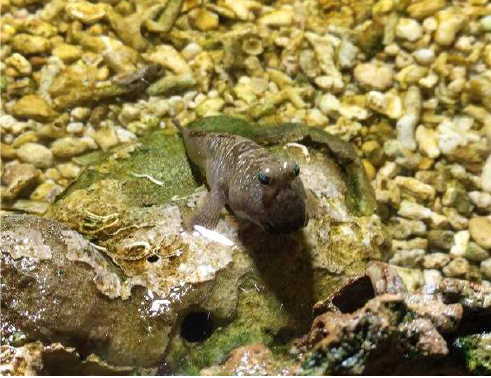
Figure 10. Mudskipper laying on a